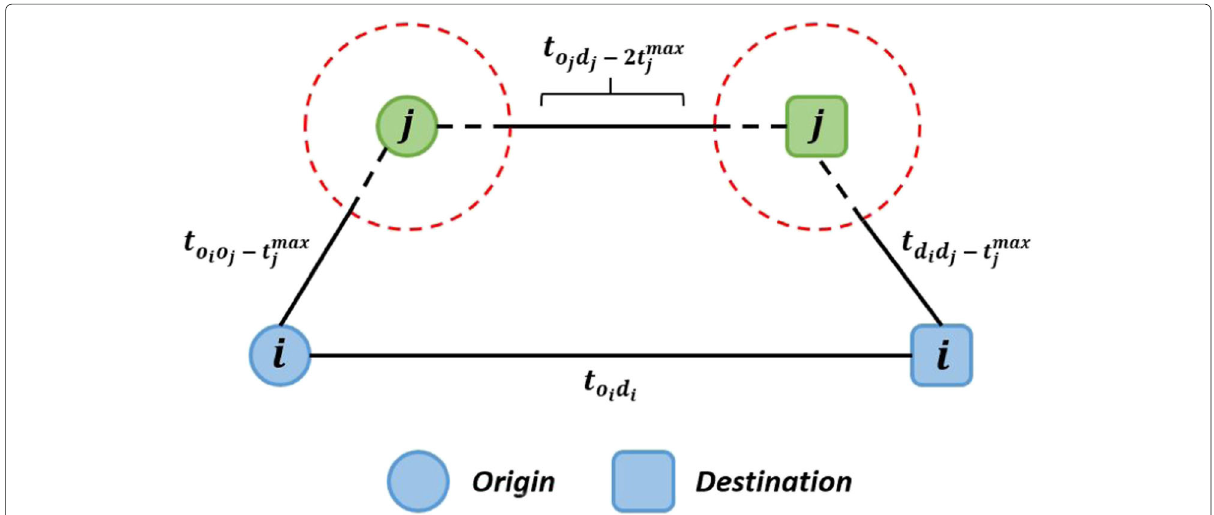
Fig. 7 Early checking - infeasibility check of a